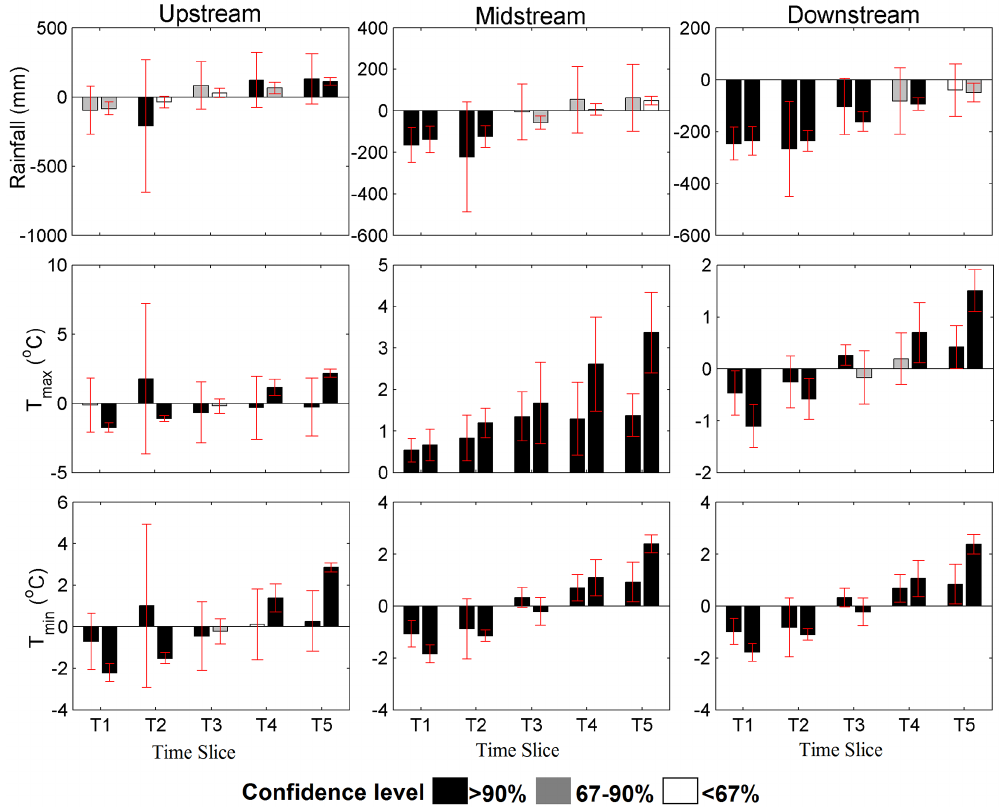
Figure 8. Change in the ensemble mean of rainfall (top panel), T max (center panel) and T min (bottom panel) from the baseline period for RCP4.5 (first bar of a time slice) and RCP8.5 scenarios (second bar of a time slice) at each time slice (T1: 2010–2020, T2: 2021–2040, T3: 2041–2060, T4: 2061–2080 and T5: